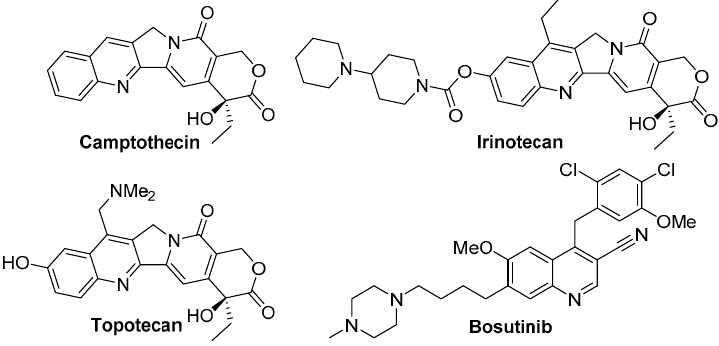
Figure 3. Structures of quinoline-containing anticancer drugs .